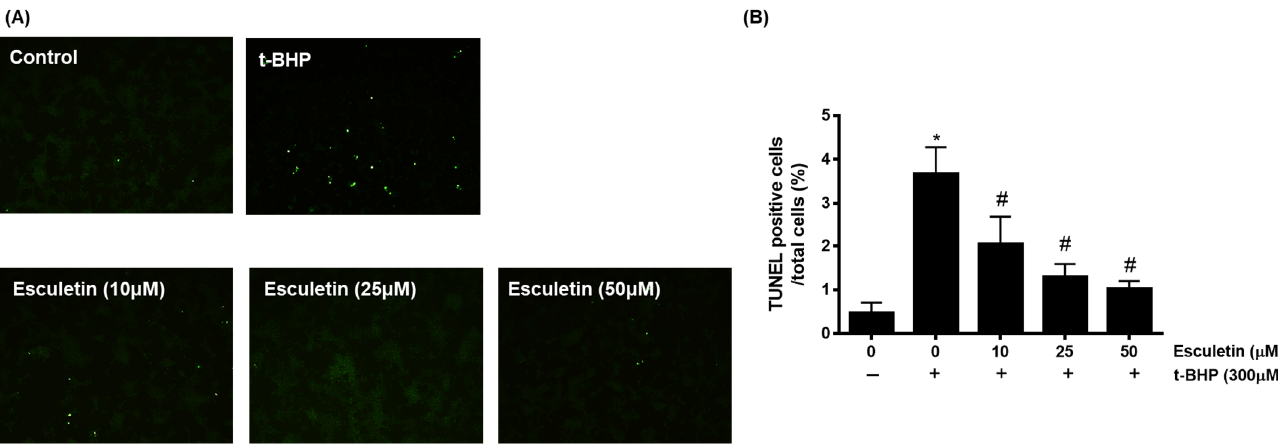
Figure 2. Effect of esculetin on t-BHP-induced ROS generation in HEK293 cells. ( A ) The changes in ROS levels in HEK253 cells exposed to t-BHP with esculetin were detected using DCFH-DA dye. ( B ) In the bar graphs, the values represent means ± SD, n = 5. * p < 0.05 vs. untreated control group, # p < 0.05 vs. t-BHP-treated group.